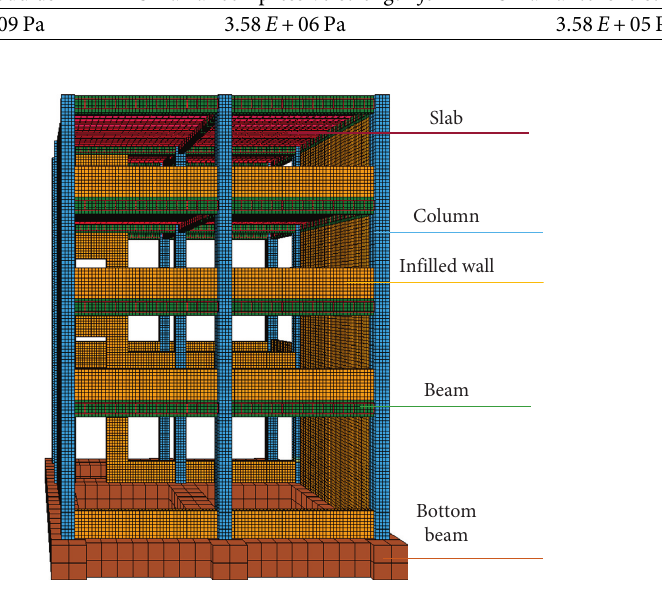
Figure 24: Numerical model of RC frame structure with infilled wall. Table 4: Test similarity ratio.